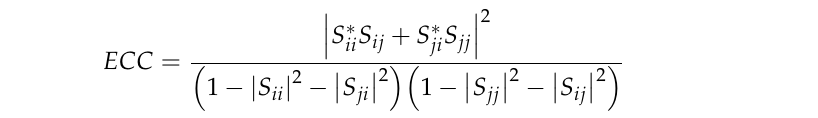
Figure 9. Simulated and measured isolation (S21, S31).